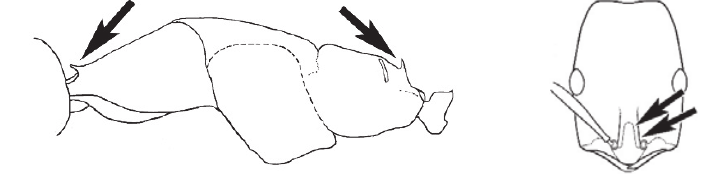
Propodeum armed with short, acute denticles; pronotum, mesonotum and propodeum flattened and delimited by blunt carinae in minor worker; antennal lobes raised, the sector between them recessed and oval-longitudinal in shape; metatibial apical spur absent (Fig. 95a–g) ( M. majeri species-